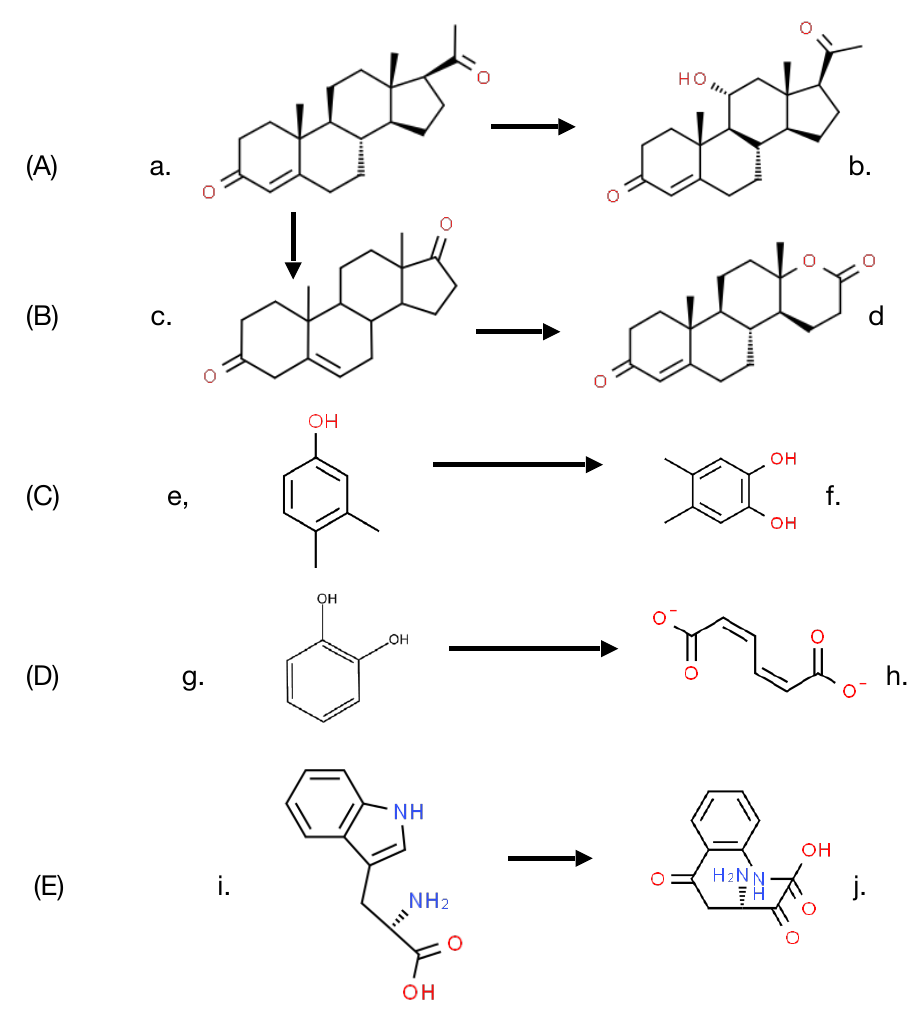
Figure 3. ( A – E ) Examples of the earliest confirmed O 2 -dependent enzymes assayed in either whole- cell or cell-free systems. a. progesterone; b. 11 α -hydroxyprogesterone; c. 4-androstene-3,17-dione; d. testololactone; e. 3,4-dimethylphenol; f. 4,6-dimethyl-catechol; g. catechol; h. cis,cis-muconate; i. tryptophan; j.